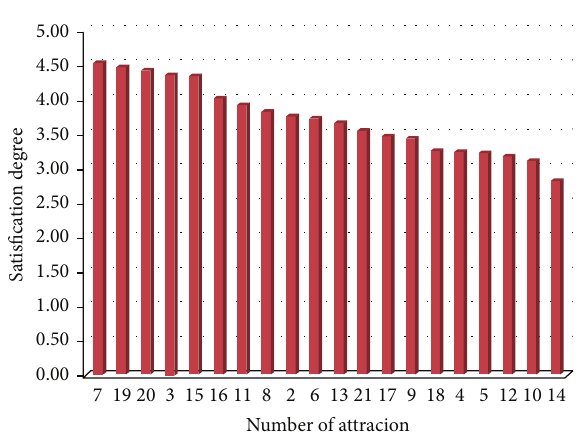
Figure 6: Motivation of the tourists.